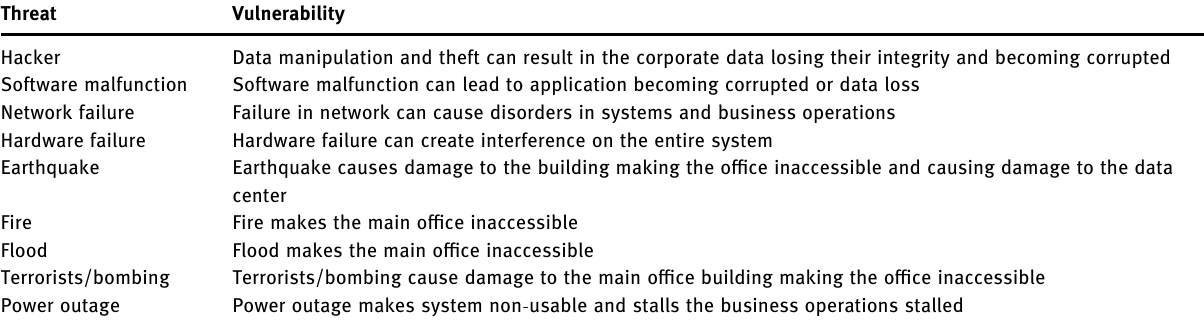
Table 2: Threats and vulnerabilities identi fi cation Threat